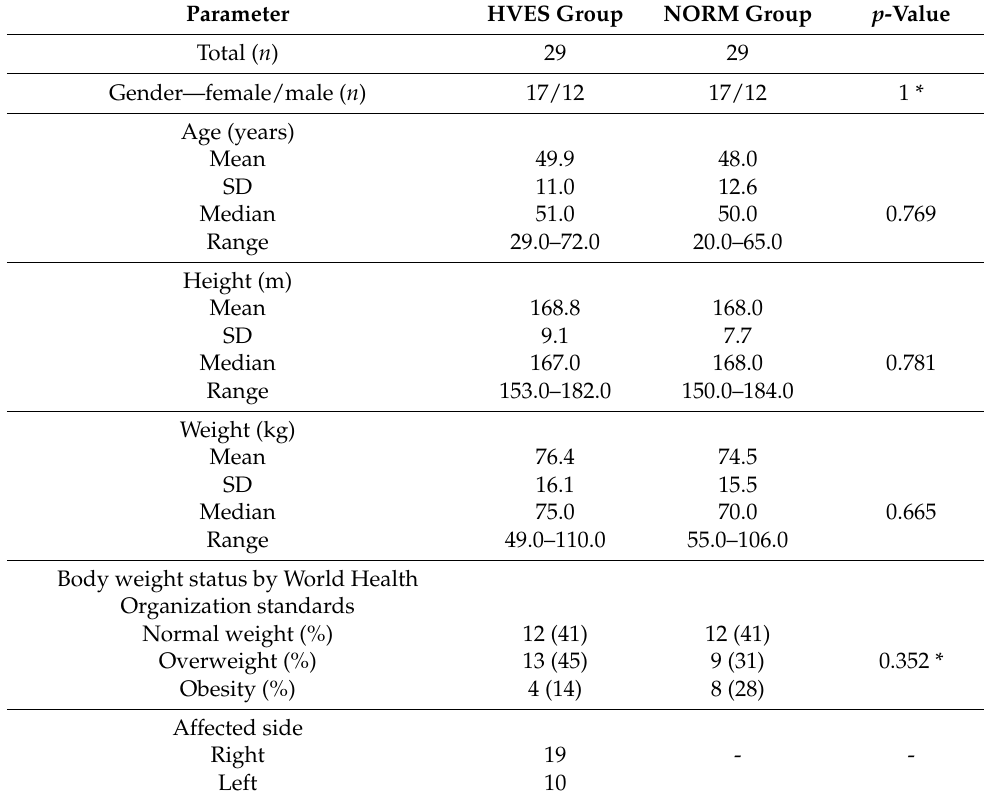
Table 1. Demographic and anthropometric characteristics of patients in HVES and NORM